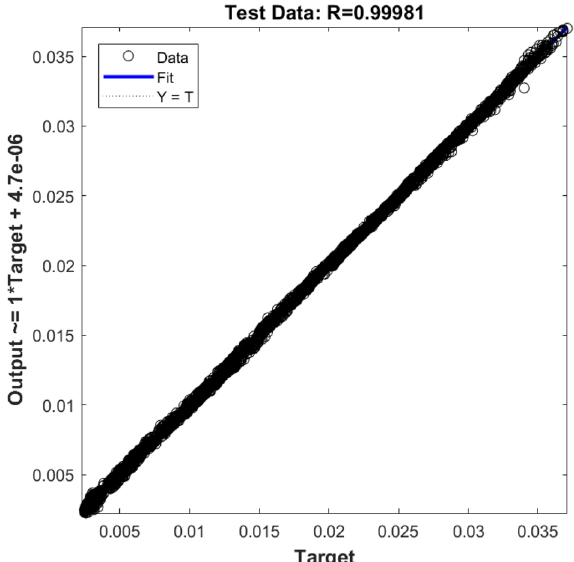
Figure 11. Testing the validation of liquid velocity for the ANFIS model with three inputs (X, Y, and Z computing nodes, the position of numerical elements). The ANFIS model’s output is the liquid velocity distribution, and it is validated against the velocity component (x-direction) in the CFD calculation (target